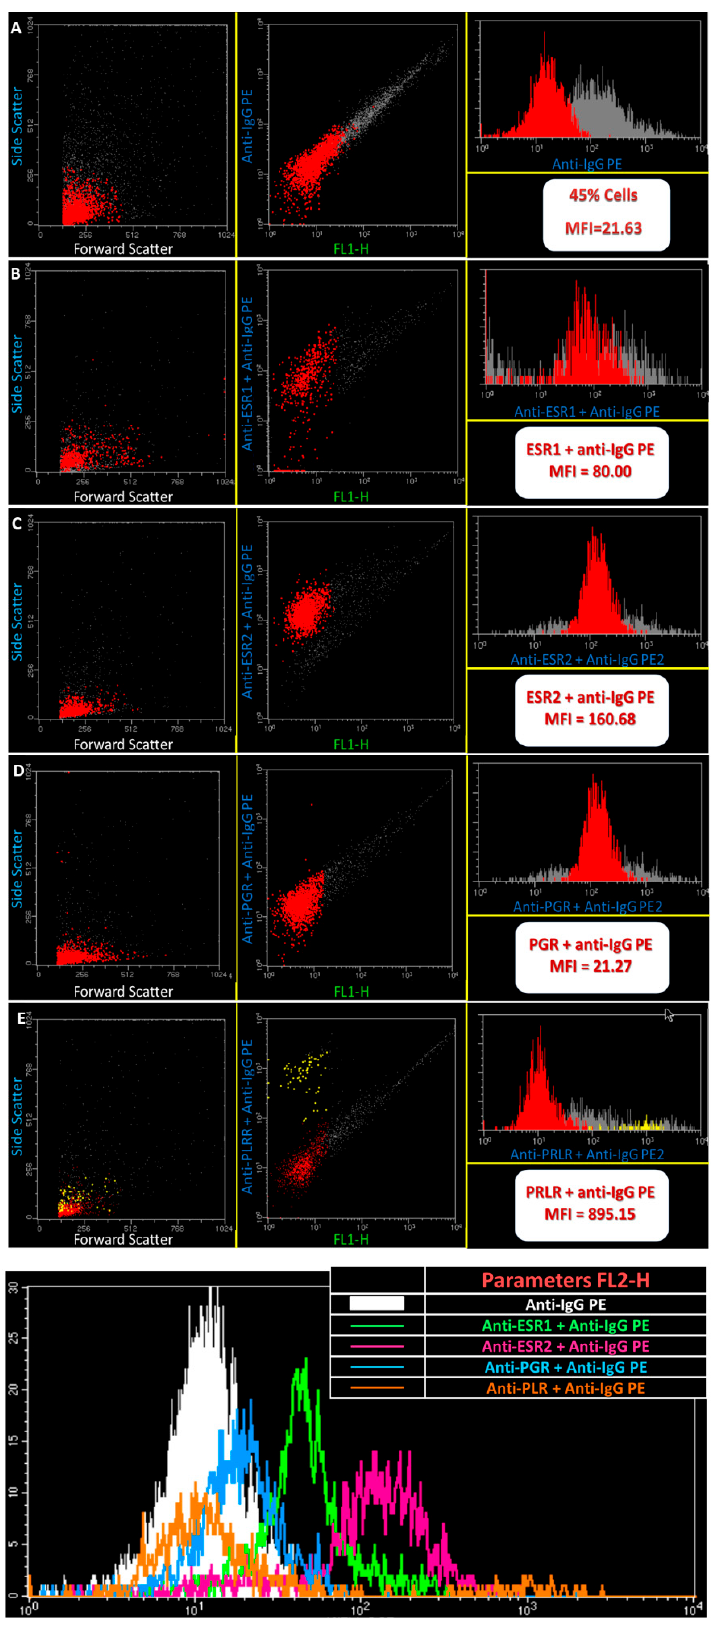
Figure 6. Flow cytometry analysis of gated cells of IGS. Examples of gated and dot plots and histograms showing the expression of ESR1, ESR2, PLRL and PGR. Shown flow cytometry data depict a positive cell expression towards the receptors under evaluation.